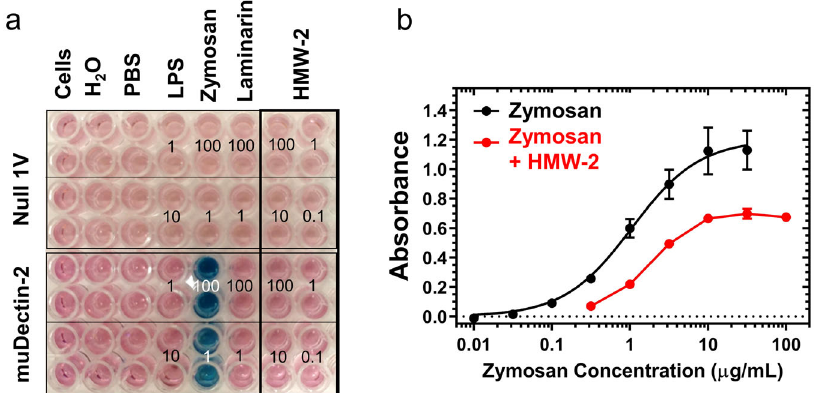
Fig. 5 HMW-2 inhibits Dectin-2-mediated cellular activation. a HMW-2 does not induce Dectin-2 activation. Dectin-2 reporter cells (HEK- blue muDectin-2) and control cells (Null 1 V) (5 × 10 4 cells per well) were exposed to different stimuli [LPS (1 and 10 µg/ml), Zymosan (1 and 100 µg/ml), laminarin (100 and 1 µg/ml) and LPS-free HMW-2 (100, 10, 1, and 0.1 µg/ml)] for 18 h. Plates were read at OD 645 nm . Figure shows representative image from two independent repeats. b . HMW-2 acts as an antagonist for Dectin-2. Dectin-2 reporter cells (5 × 10 4 cells per well) were preincubated with 0.3 µg/ml of LPS-free HMW-2 for 1 h and then exposed to different zymosan doses for 18 h. Plates were read at OD 645 nm . The fi gure shows representative results from 3 independent